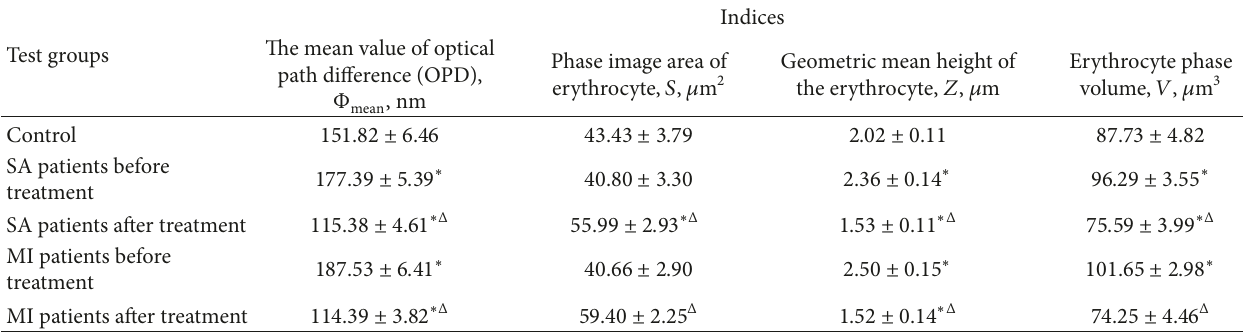
Table 2: Morphometric characteristics of erythrocytes from apparently healthy people and from patients with SA and MI before and after treatment, 𝑛 = 20 ( V ±